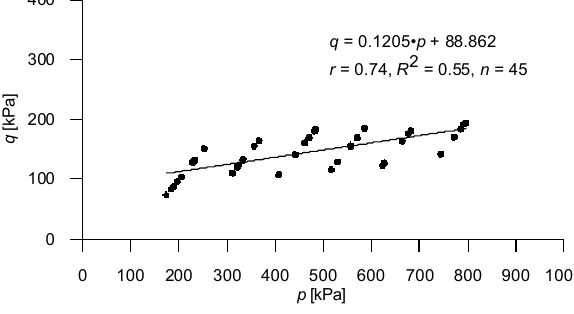
Figure 15: Result of strength tests for soil A-4.